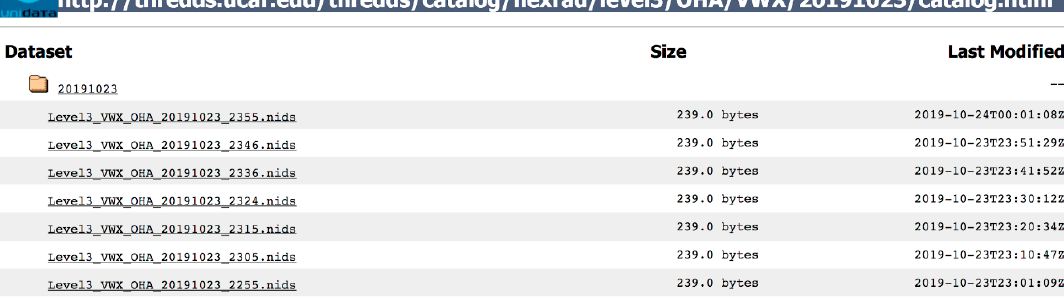
Figure 4. Data resource (dataset) listing at the bottom of the catalog hierarchy. Only first seven entries shown here. More entries omitted.